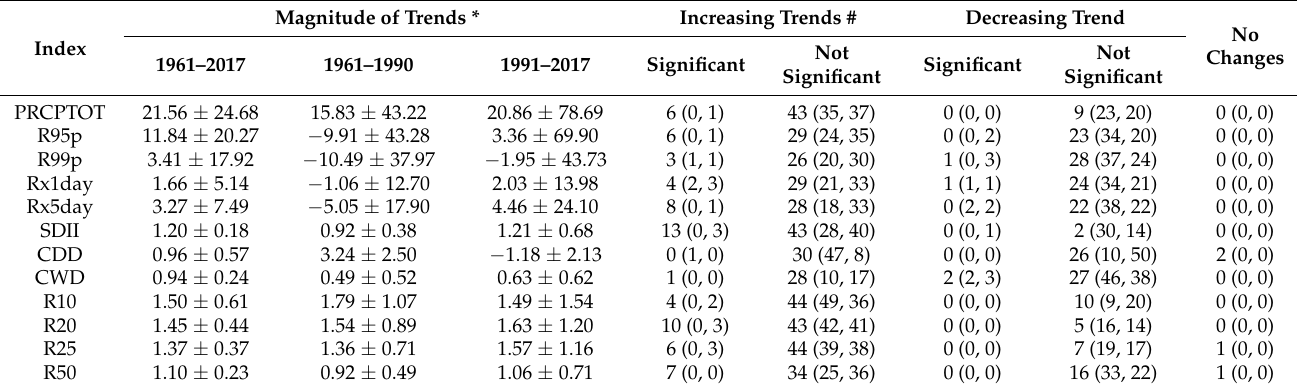
Table 2. Statistical results of trends in precipitation extremes over the